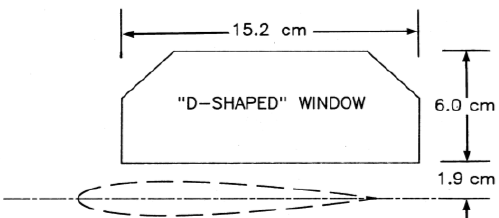
Figure 2. Geometry of the “D-shaped” window with a generic airfoil showing approximate location. From [27].